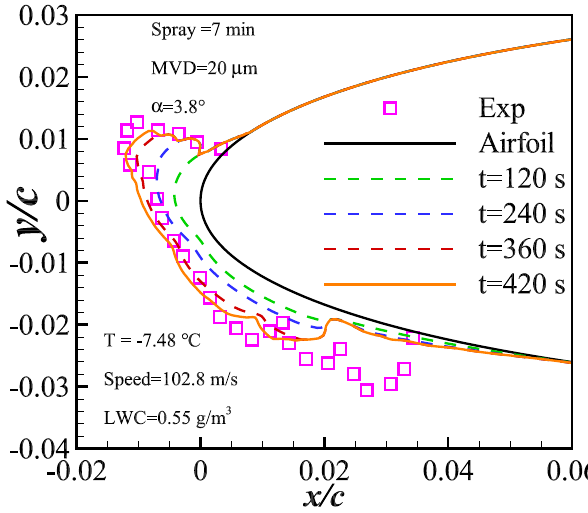
Figure 2. Glaze ice